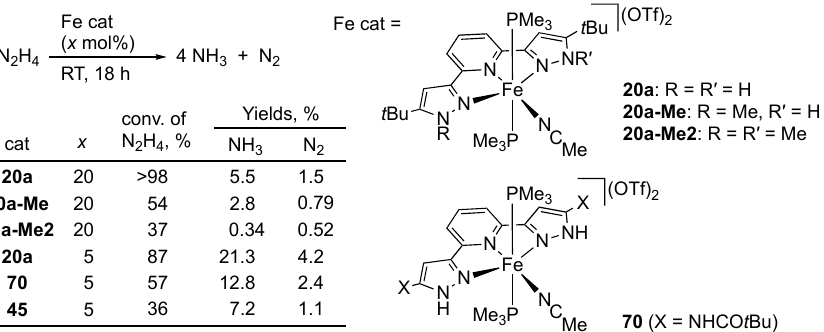
Scheme 20. Catalytic disproportionation of hydrazine with protic pincer-type iron complexes.